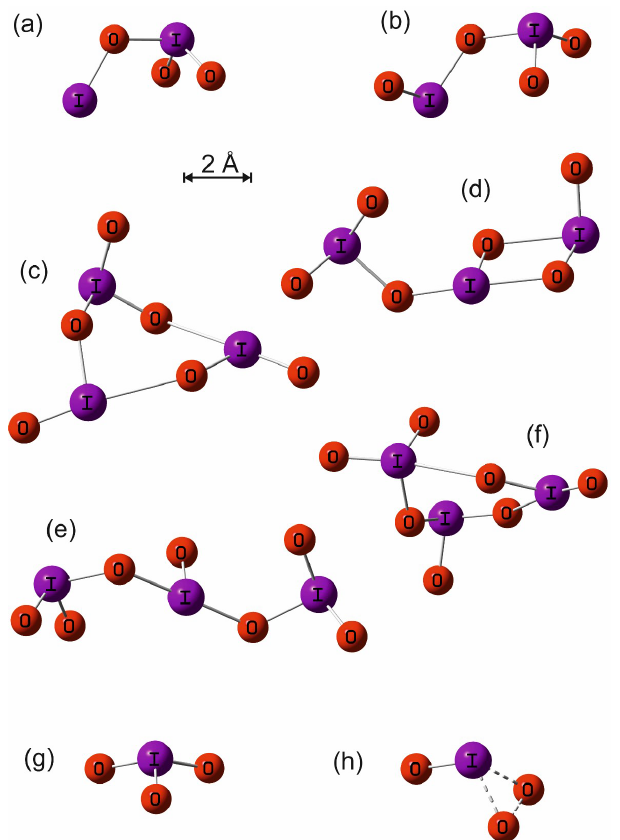
Figure A1. Molecular geometries of I 2 O 3 , I 2 O 4 , I 3 O 6 (cyclic), I 3 O 6 (linear), I 3 O 7 (cyclic), I 3 O 7 (linear), IO 3 , and the transition state for dissociation of IO 3 to IO + O 2 , calculated at the B3LYP/gen level of theory (see main text for details).